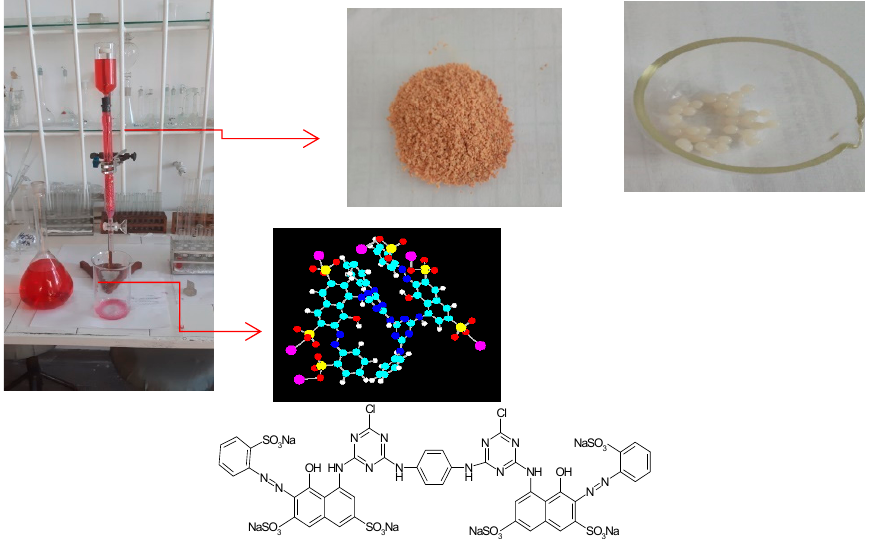
Figure 1. The presentation of mobile (BRed anionic dye solution) and stationary (biosorbent) phases used in the fixed-bed column for biosorption process study.